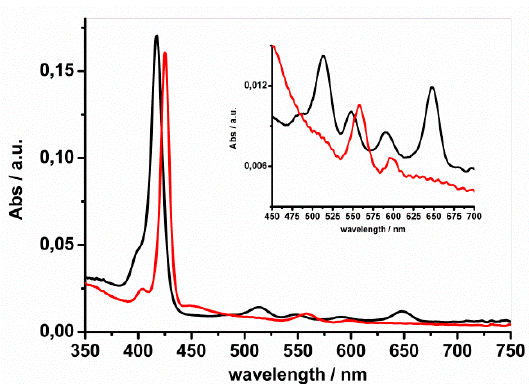
Figure 3. UV–Vis spectra of toluene:DMF (50:50 v : v ) solutions in which PES mats impregnated with H 2 TPP (black line) or ZnTPP (red line) were dissolved. The inset shows the Q-bands region in detail. The porphyrin concentration on mats (having 2 × 2 cm 2 surface area and 2.4 mg weight, dissolved in 2.5 mL of toluene:DMF 50:50 v : v ) was spectrophotometrically estimated to be 0.32 μ M and 0.30 μ M for H 2 TPP and ZnTPP, respectively (~0.02% w / w for both H 2 TPP and ZnTPP).